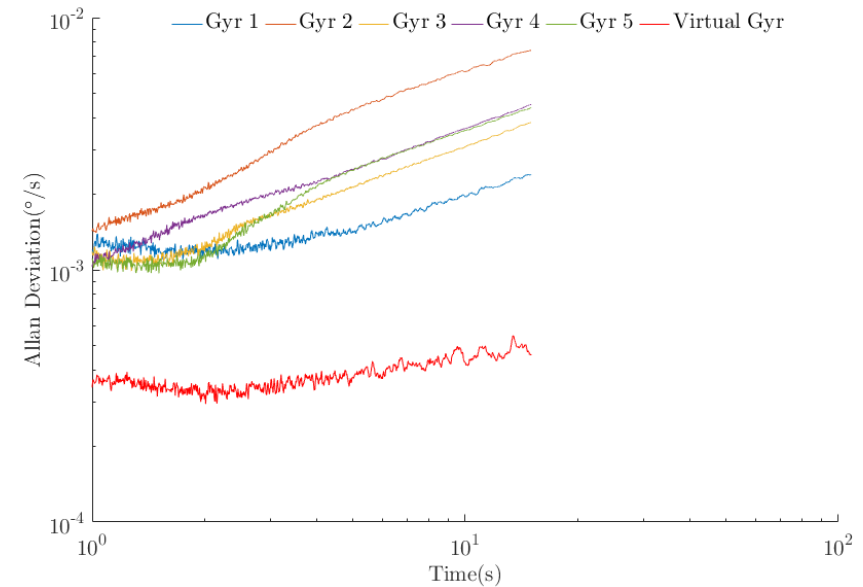
Figure 11. Double logarithmic graph of the Allan variance method (the Allan variances of the five original data points are visualized).